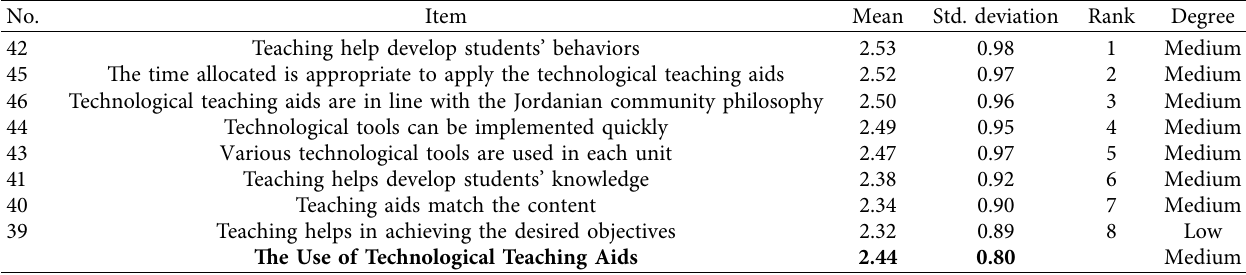
Table 6: Means, standard deviations, ranks, and degree of the study sample on the field of The Use of Technological Teaching Aids. No. Item Mean Std. deviation